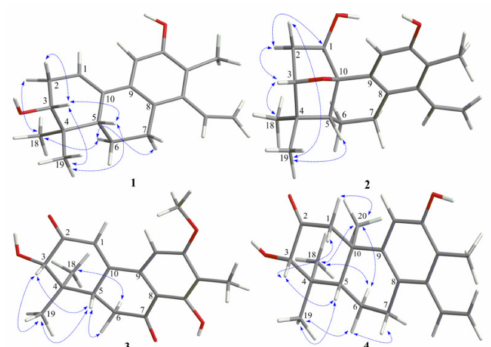
Figure 3. Key ROESY correlations of compounds 1 – 4 .